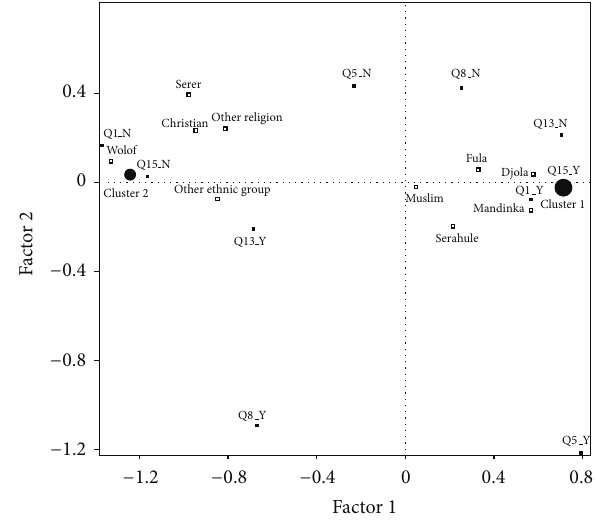
Figure 1: Multiple correspondence